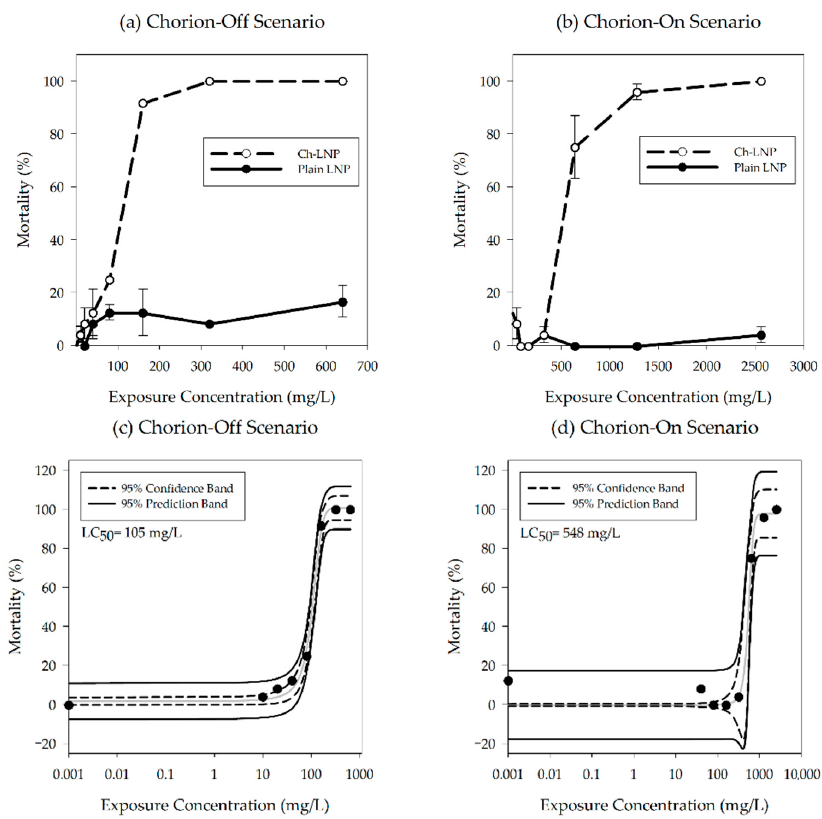
Figure 2. Percentage of observed mortality at 120 hpf for embryonic zebrafish exposed to particle suspensions with their ( a ) chorion removed and ( b ) with chorion intact; concentration-response curves showing predicted mortality at 120 hpf for the groups exposed to Ch-LNPs with ( c ) chorion removed and ( d ) chorion intact; a sigmoidal relationship was fit to experimental data to estimate LC 50 values and 95 percent confidence intervals. Table 2. Calculated LC 50 values at 120 hpf for Ch-LNPs in both experimental scenarios.